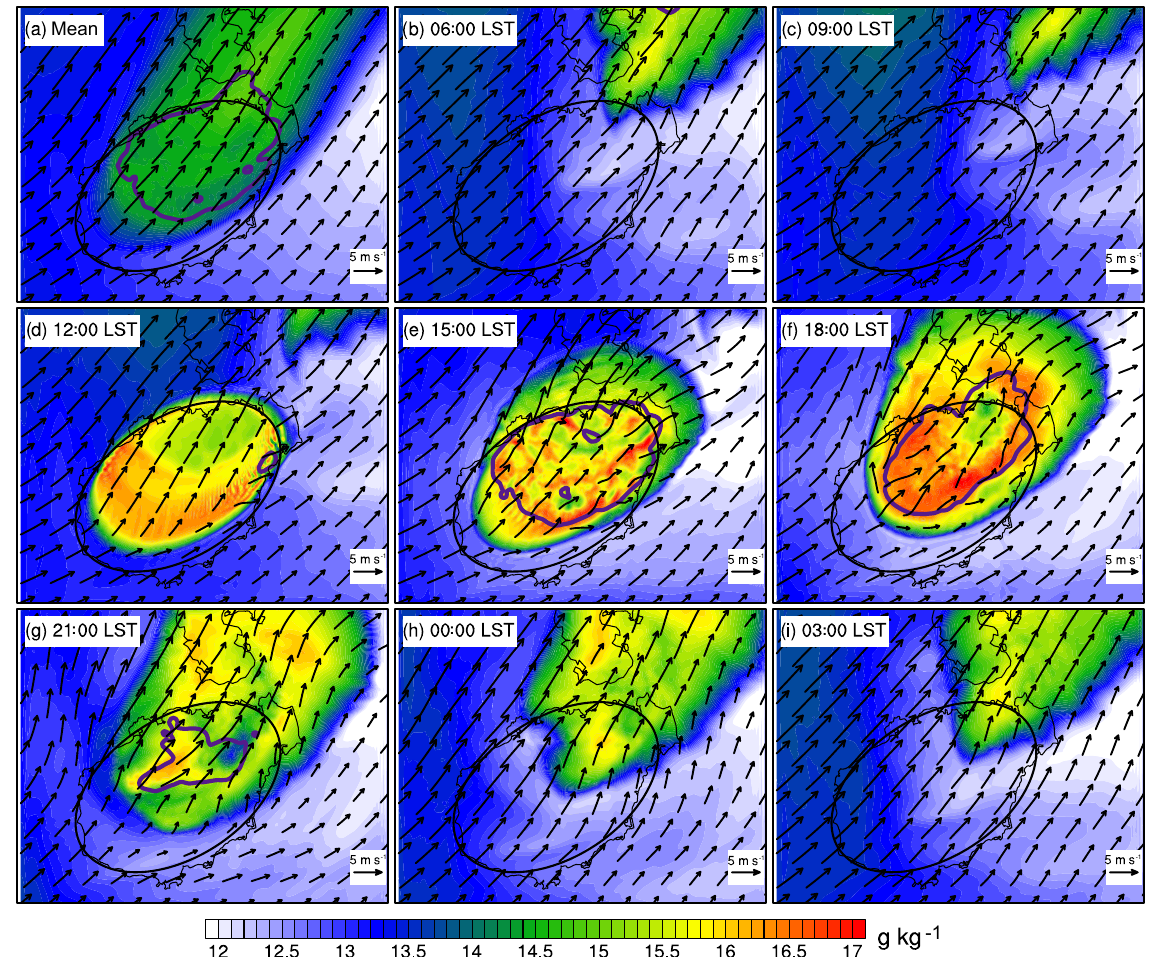
Figure 11. Water vapor mixing ratio (shading) and horizontal wind (vectors) at 850hPa, and hourly precipitation accumulations > 0 . 1mm (thick purple contours) (b–i) every 3h and (a) averaged over all